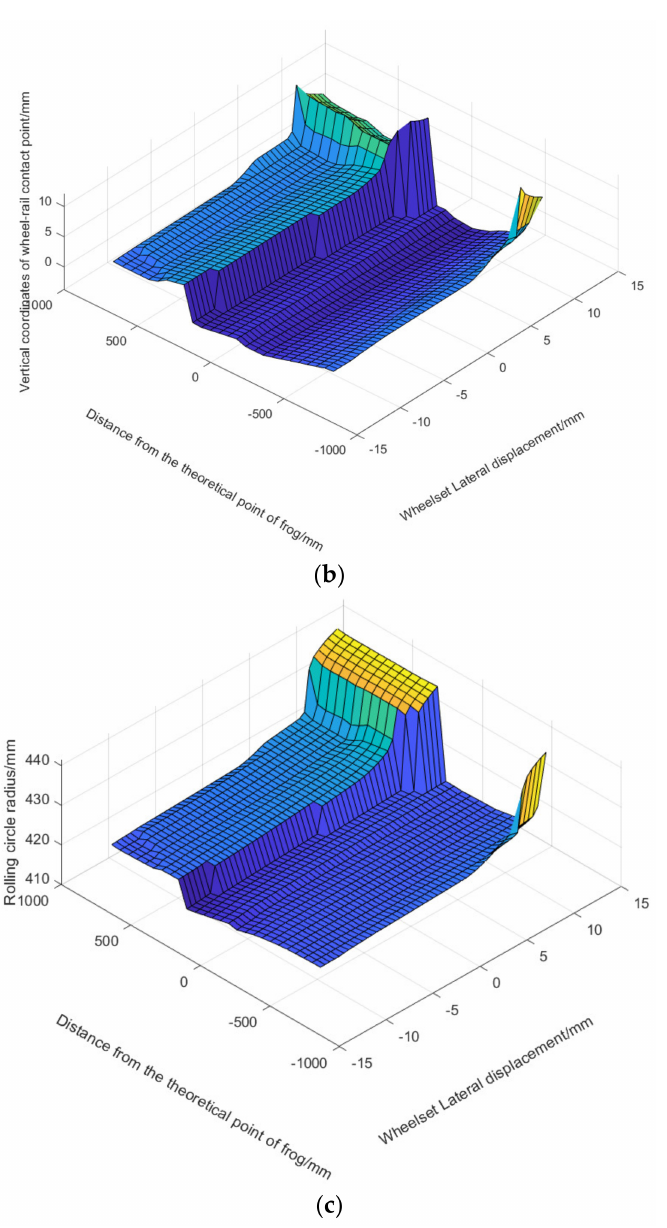
Figure 1. Wheel/rail contact calculation results of key sections: ( a ) Lateral coordinates of wheel/rail contact point; ( b ) Vertical coordinates of wheel/rail contact point; ( c ) Rolling circle